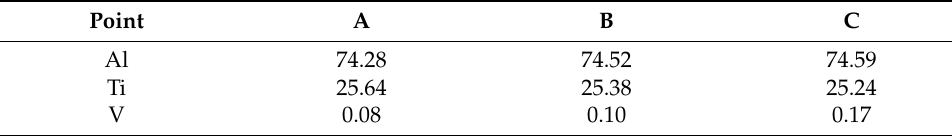
Figure 2. Morphologies of DRL and EDS line scanning of TC4/Al–2Li; ( a , b ) 680 ◦ C/0.5 h; ( c , d ) 680 ◦ C/1 h; ( e , f ) 680 ◦ C/2 h. Table 2. EDS analysis of the results in Figure 2